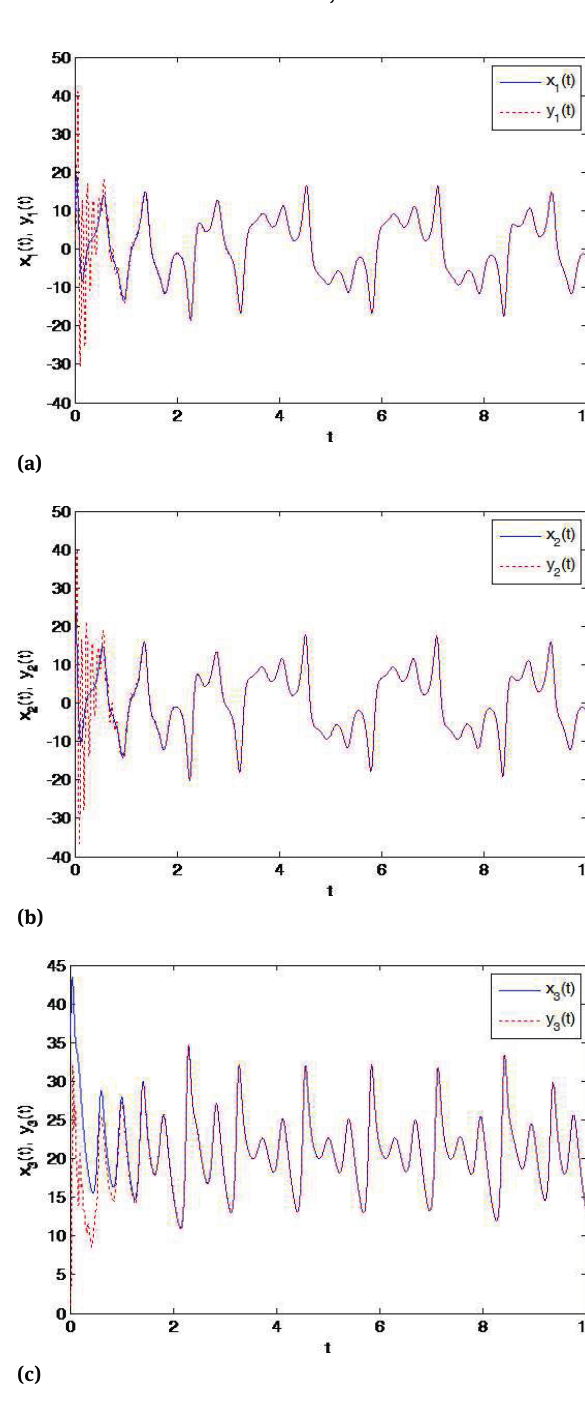
both standard and fractional order derivatives applying the active control method and backstepping method has been done.